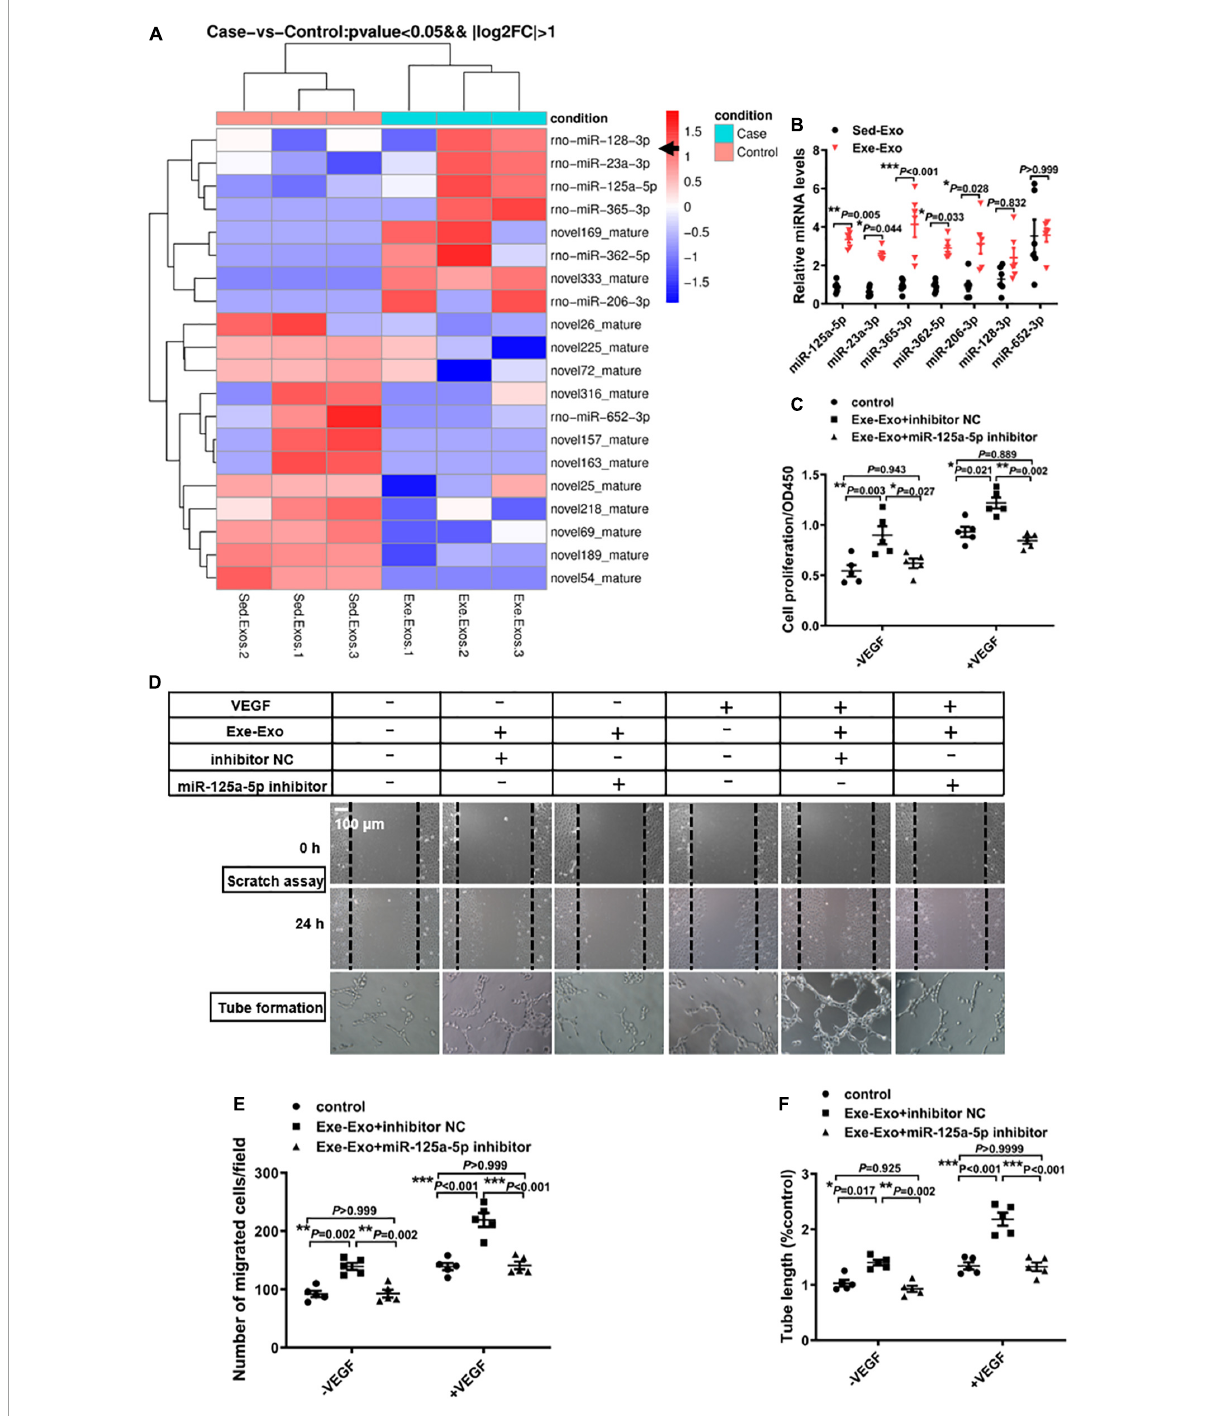
FIGURE3 miR-125a-5p is essential in Exe-Exo-induced HUVEC proliferation, migration and tube formation. (A) Exosomal miRNA sequencing assays were performed in Exe-exo and Sed-exo. Heat map showing the differential expression of miRNAs between the 2 groups and with a level change of greater than twofold ( p < 0.05). Sed-Exo, exosomes purified from the plasma of sedentary rats. Exe-Exo, exosomes purified from the plasma of exercised rats. N = 3 per group. (B) RT-qPCR analysis of the 7 differentially expressed known miRNAs in Sed-Exo and Exe-Exo. Data are normalized to spiked cel-miR-39 ( N = 6). (C–F) Cultured HUVECs were transfected with an miR-125a-5p inhibitor (100 nM) or inhibitor NC (100 nM) and incubated with Exe-Exo (50 µ g/ml) for 48 h, the followed by starvation for 6 h and stimulation with VEGF165 (100 ng/ml) for 20 min. Cell proliferation was determined by CCK8 (C). Cell migration was determined by scratch assay, representative images (D) and a quantitative analysis (E). Representative images (D) and a quantitative analysis (F) of tube formation. Each experiment was repeated 5 times. * P < 0.05, ** P < 0.01, *** P < 0.001. Scale bar = 100 µ m as presented in the above images. Data are means ±